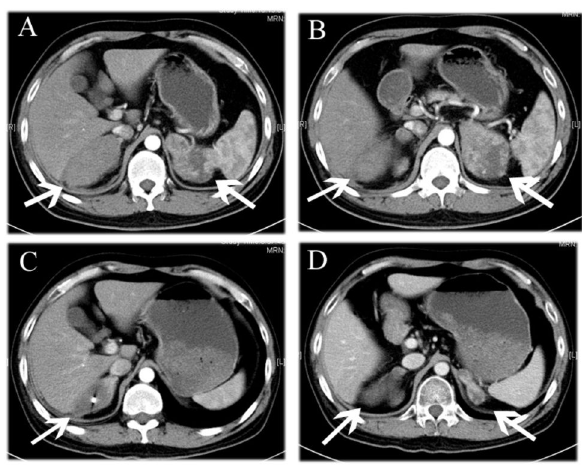
Figure 3. Comparison before CyberKnife treatment with that at 2 months after treatment. A 40 years old male patient with adenocarcinoma involving the right lung with metastases in the left and right adrenal after 4 cycles of chemotherapy. (A, B) Abdominal transverse enhanced CT scanning shows bilateral adrenal metastasis. (C, D) Abdominal transverse enhanced CT at 2 months after CK treatment shows bilateral metastases were significantly reduces with the previous. The patient had varying degrees of lower back and abdomen swelling pain before treatment, the symptom were relieved at the time when the patient was followed up.